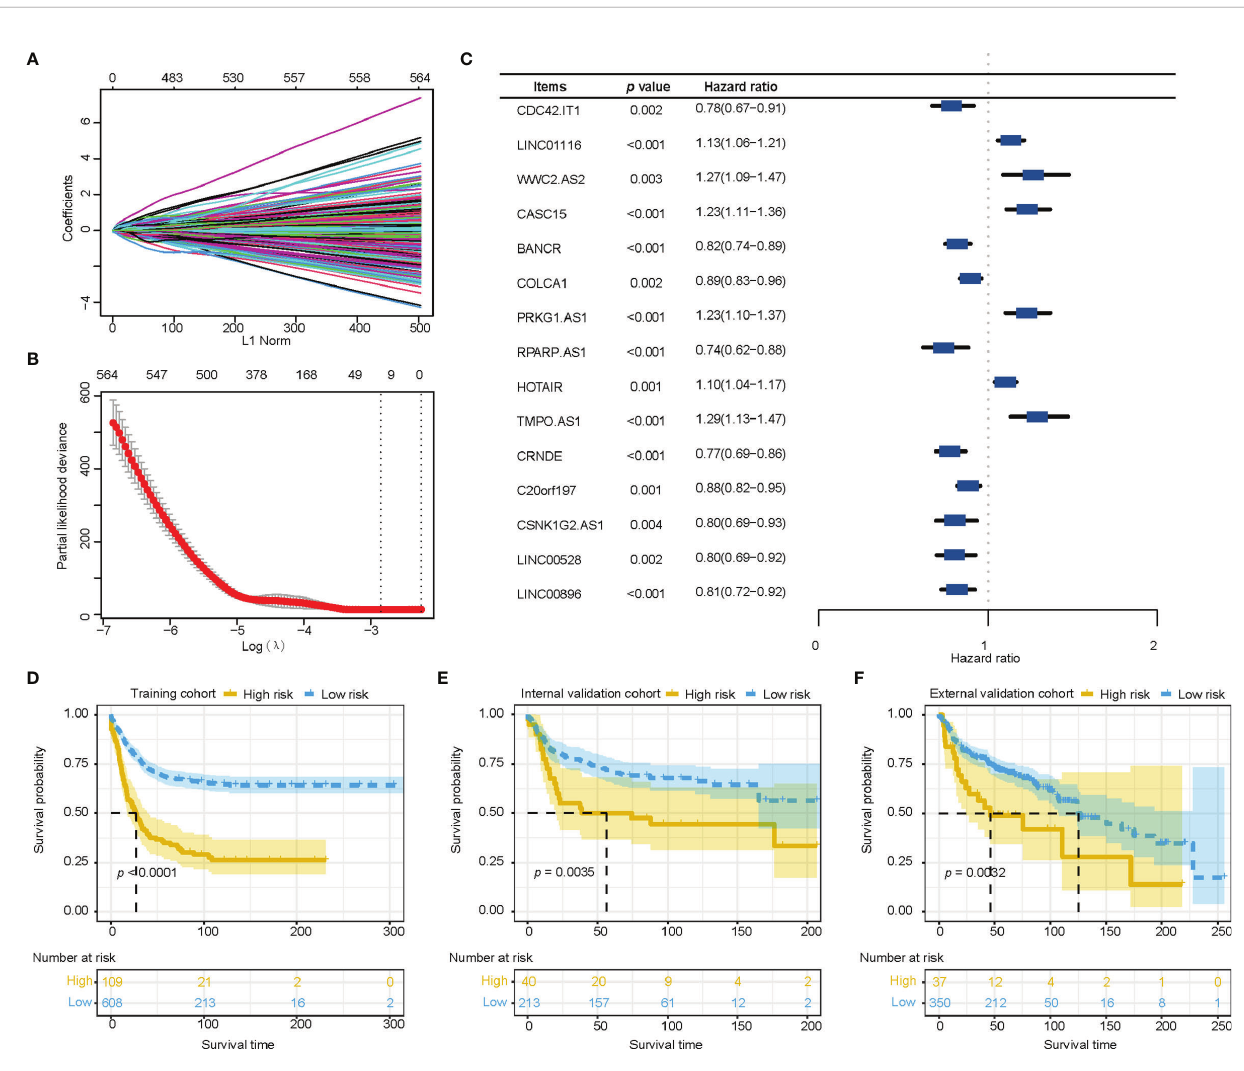
Frontiers in Oncology |